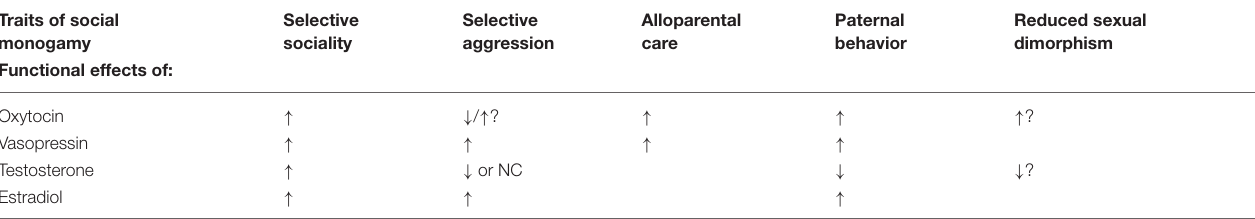
TABLE 3 | Features of social monogamy and functional effects of associated peptide and steroid hormones (based on the prairie vole model). Traits of social